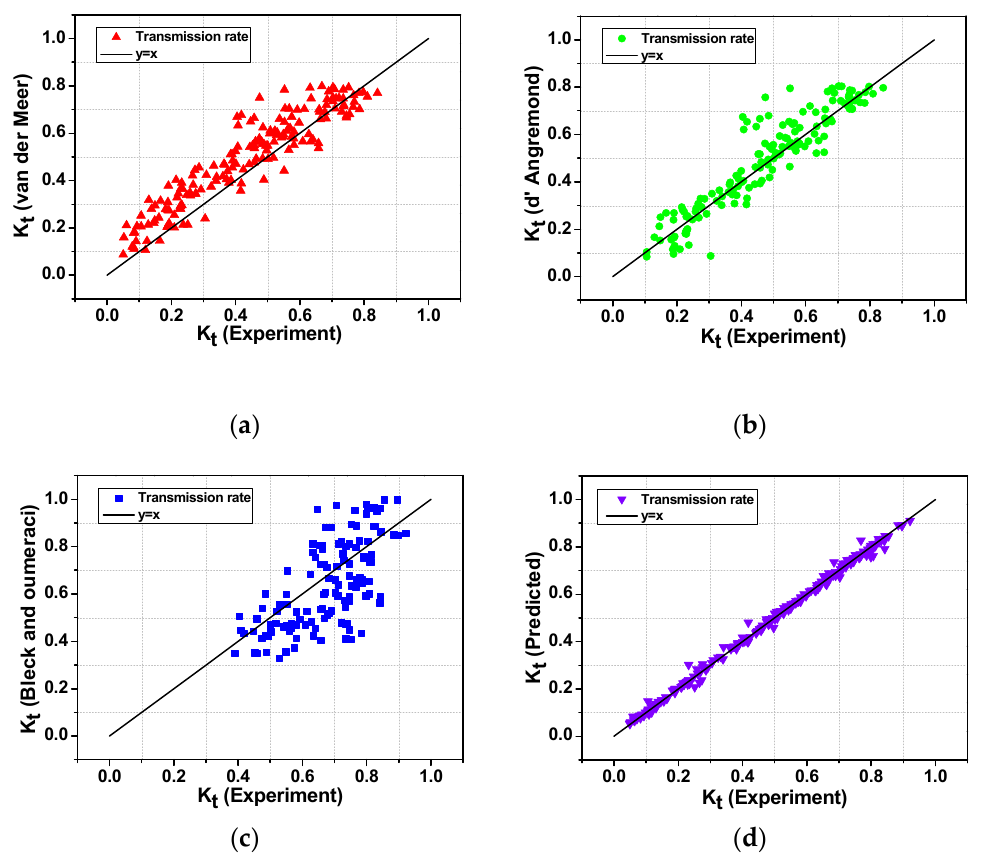
Table 6. Statistical parameters of the results.